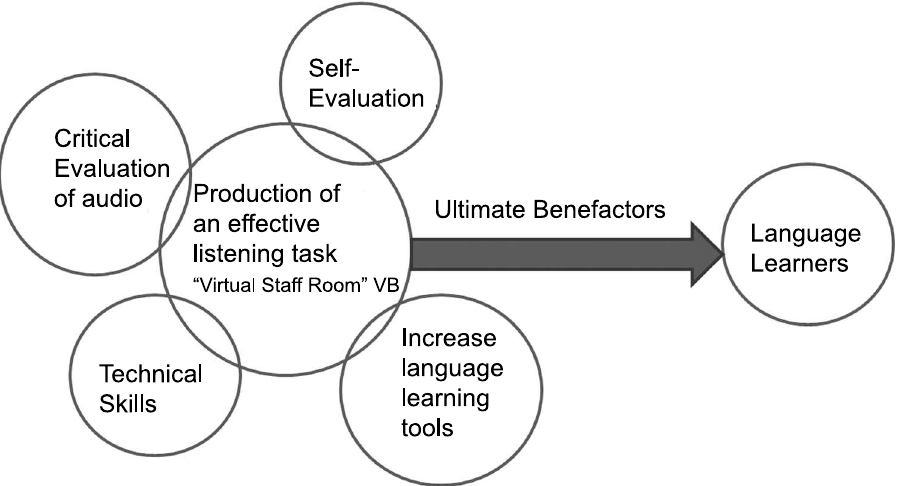
Figure 1. Development of the pedagogical toolkit.